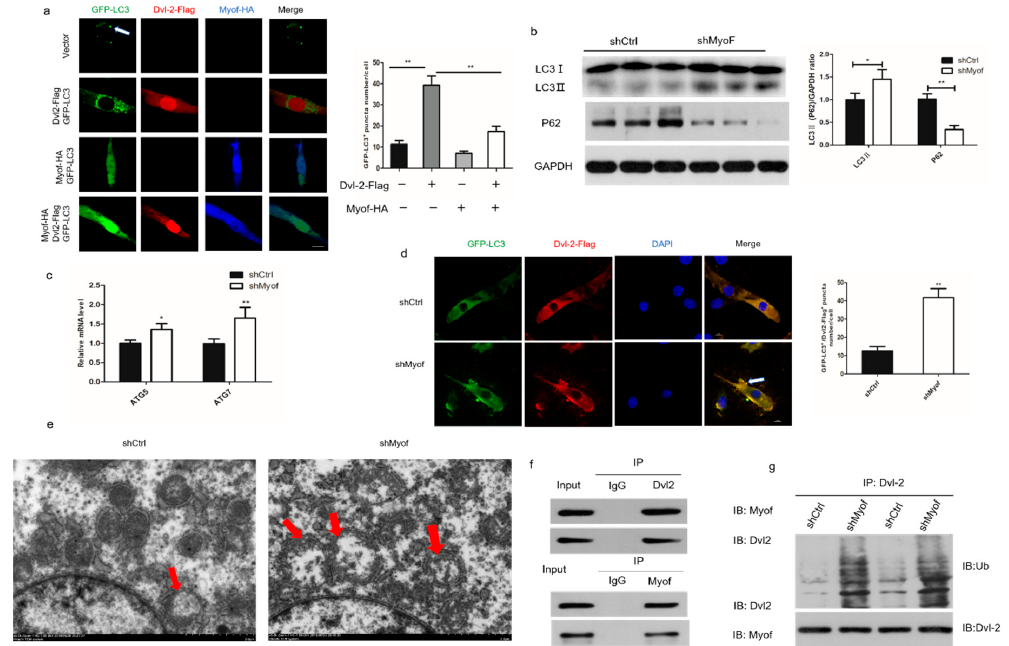
Figure 6. MyoF stabilizes Dvl-2 by antagonizing LC3-mediated autophagy. ( a ) Immunofluorescence analysis of GFP-LC3 + puncta in C2C12 cells after transfection with GFP-LC3 and Dvl-2-Flag plasmids, GFP-LC3 and MyoF-HA plasmids, or GFP-LC3, Dvl-2-Flag, and MyoF-HA plasmids. The bar graph on the right shows the number of GFP-LC3 + puncta in each cell. ( b ) Western blot analysis of p62 and LC3 Ⅱ protein levels in cells transfected with shCtrl or shMyoF. ( c ) qRT-PCR analysis of ATG5 and ATG7 mRNA levels in cells transfected with shCtrl and shMyoF. ( d ) Immunofluorescence analysis of GFP-LC3 + / Dvl-2-Flag + puncta in cells transfected with shCtrl or shMyoF. ( e ) The ultrastructure of cells transfected with shCtrl or MyoF observed by transmission electron microscopy ( × 5000). ( f ) Reciprocal coimmunoprecipitation analysis of MyoF and Dvl-2 in C2C12 cells. IB immunoblotting, IP immunoprecipitation. ( g ) Western blot analysis of the Dvl-2 ubiquitination levels in cells transfected with shCtrl or shMyoF. Data represent means ± SEM ( n = 3 independent cell cultures). * p < 0.05; ** p <